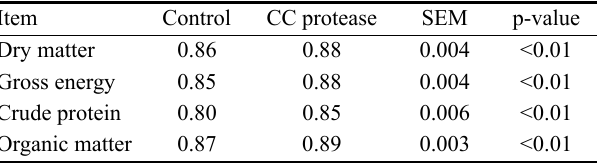
Table 4. Apparent total tract digestibility of nutrients in basal diet or diet supplemented with 0.2 g/kg proteases for pigs (Exp. 1)